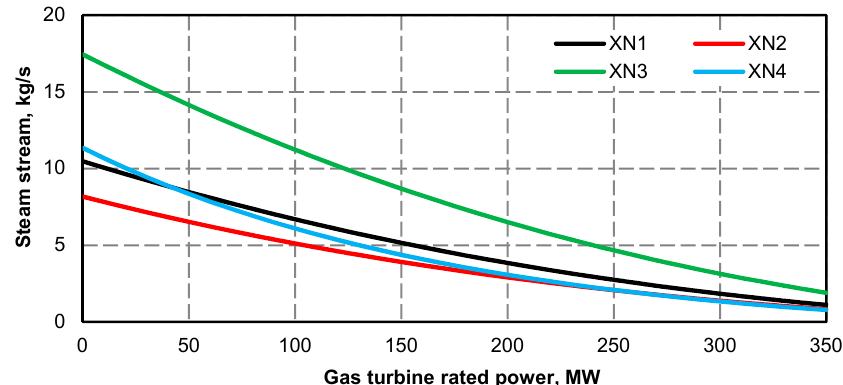
Figure 18. The streams of extraction steam for the XN1–XN4 low-pressure regeneration exchangers for a maximum fixed stream of 319.4 kg/s fresh steam fed to the steam turbine as a function of gas turbine rated power.